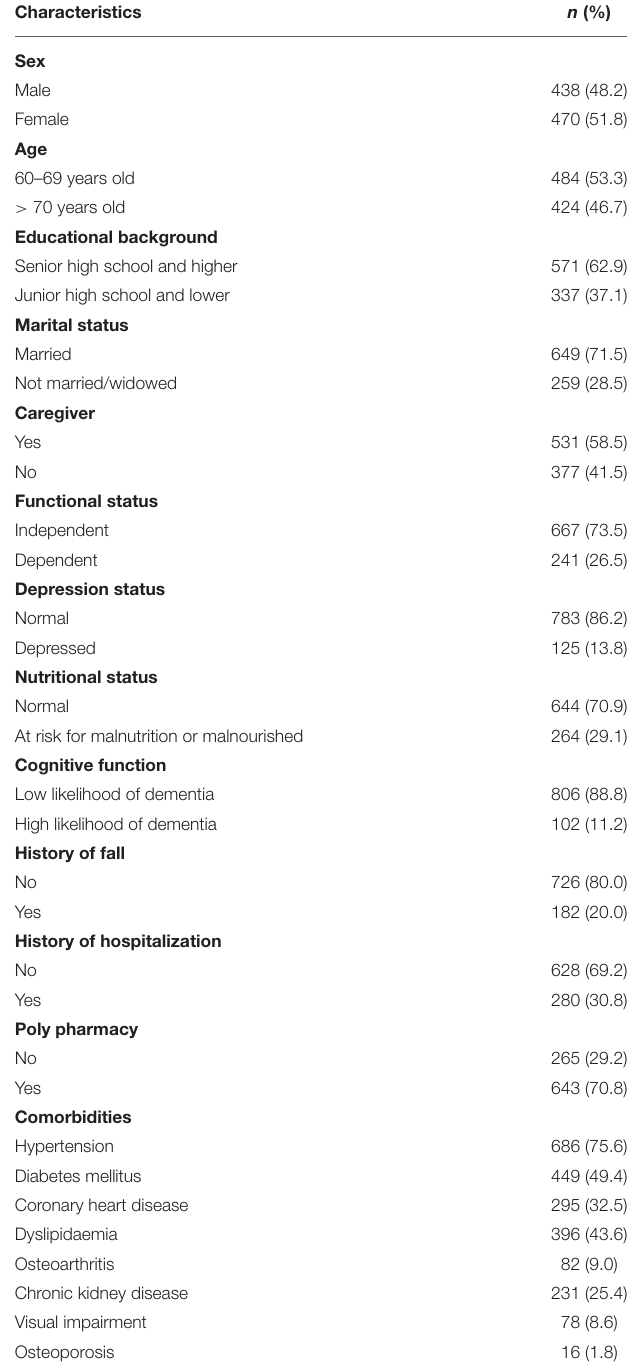
TABLE 1 | Characteristics of Subjects ( n =